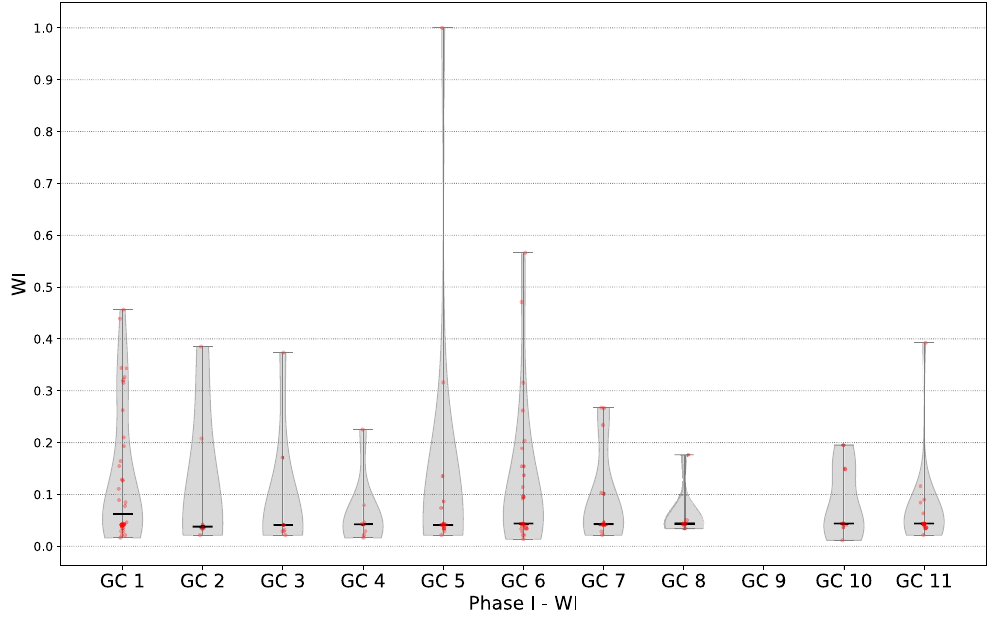
Figure 5: WI distribution of Dunaújváros Phase I ( c. 2200 – 1950 BCE ) by GC. Bold black bars indicate the median.